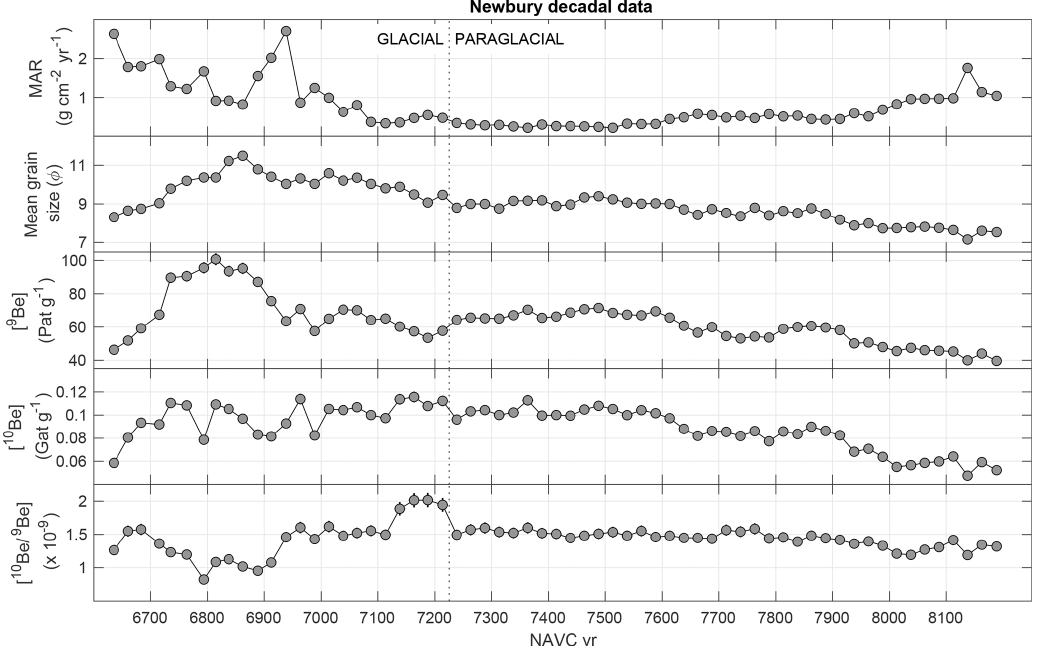
Figure 19. Sedimentological data and Be concentrations for the decadal-resolution record at Newbury (NEWB; see Figs. 1 and 2).